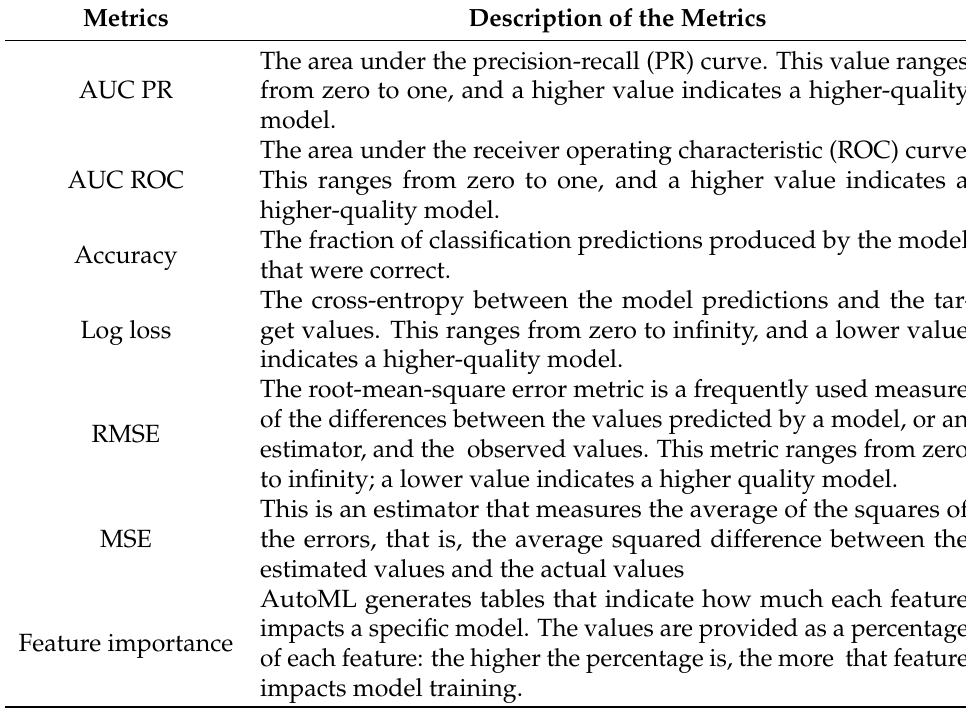
Table 3. Evaluation metrics of the classification